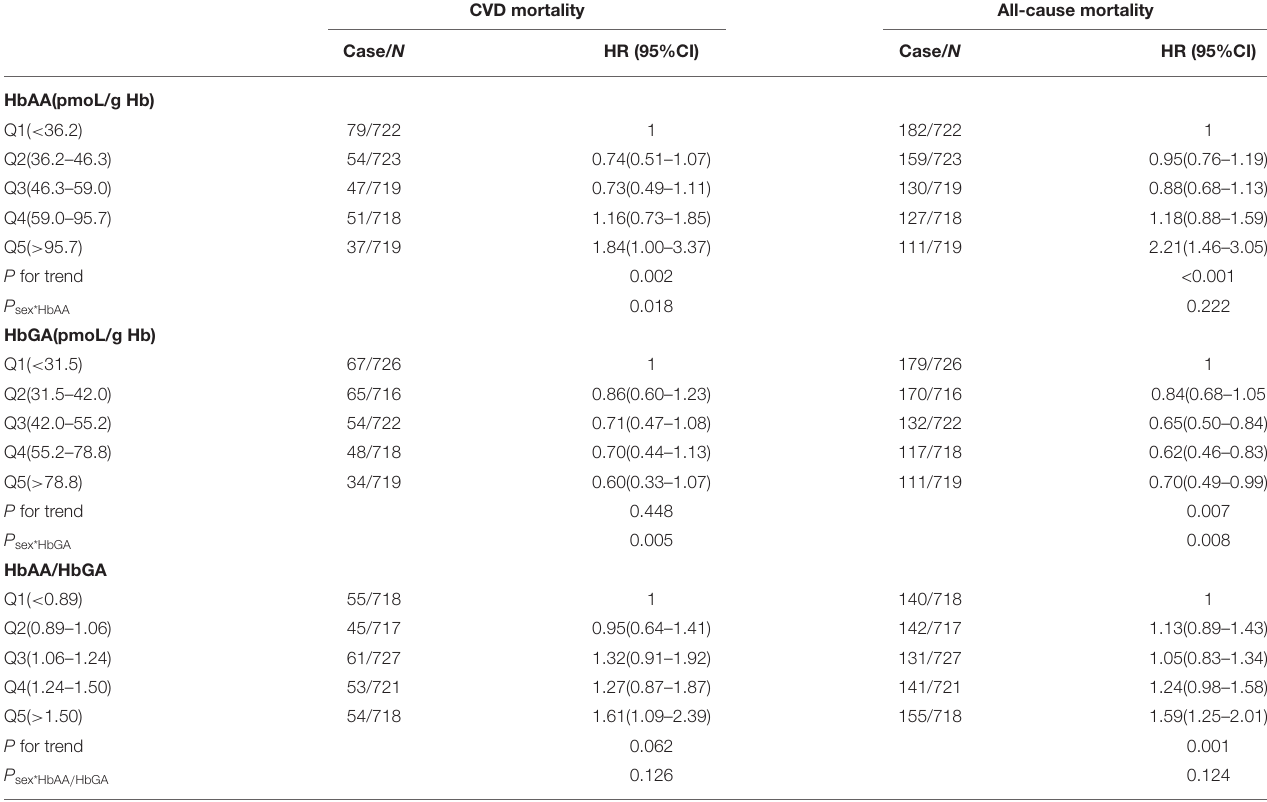
TABLE 2 | Adjusted hazard ratios ( HR s) for the associations between HbAA, HbGA, HbAA/HbGA and CVD or all-cause mortality in the total hyperglycemia